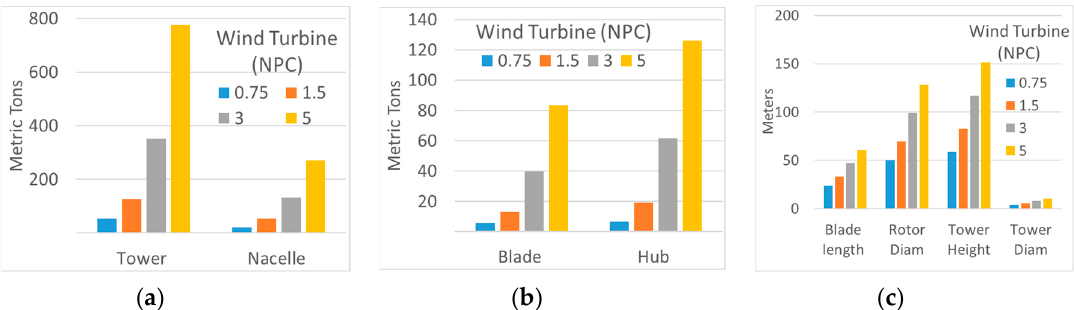
Figure 2. Wind turbines’ ( a , b ) mass and ( c ) dimensions according to its Name Plate Capacity (NPC) as modeled by National Renewable Energy Laboratory’s (NREL) Griffin [44], Malcolm et al. [45] and Rinker et al. [46].